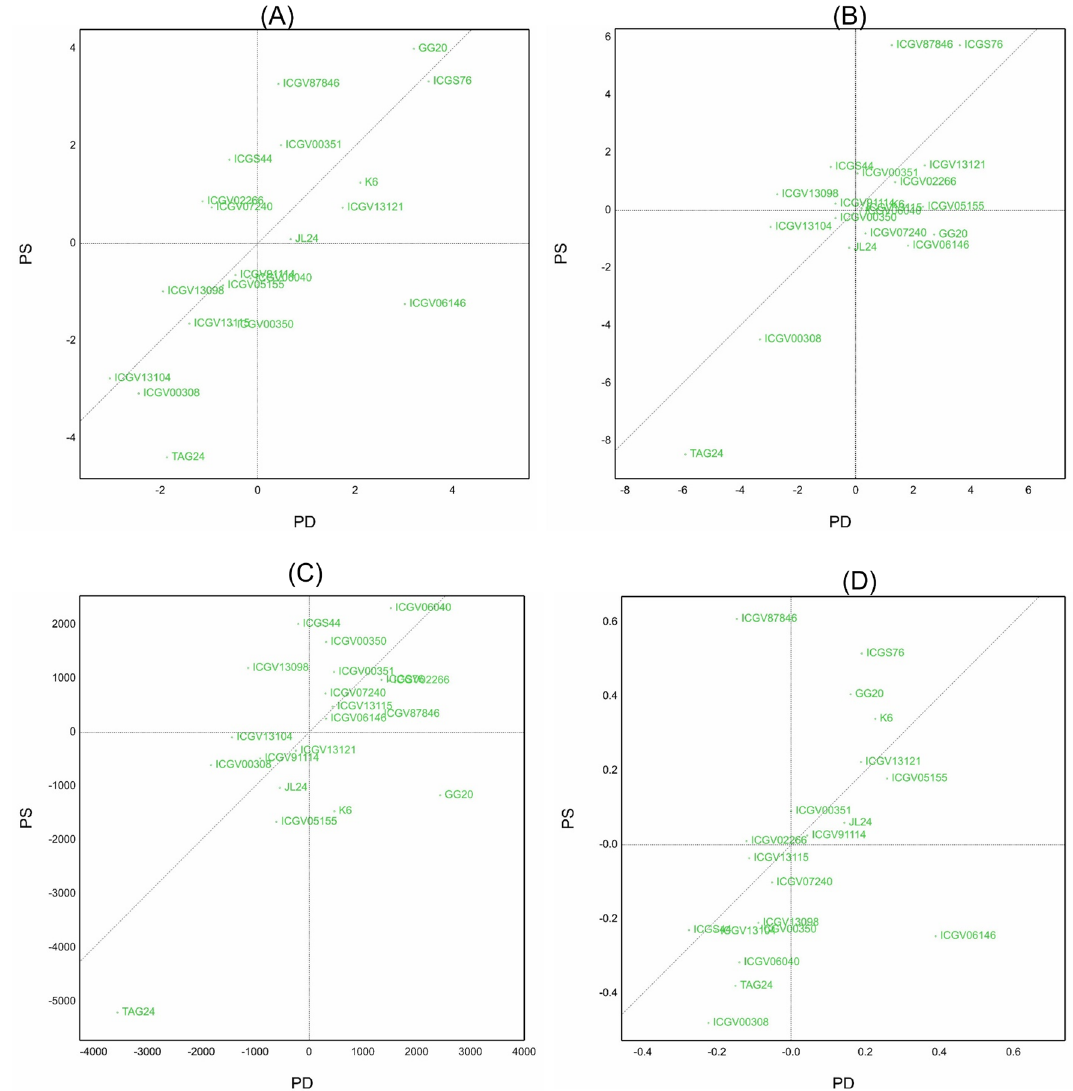
Figure 1. ( a ) Scatter plot showing distribution of genotypes for various traits under lysimeter experiment ( A ) Leaf dry weight (g) ( B ) stem dry weight (g). PD—Phosphorus deficiency; PS—Phosphorus sufficiency. ( b ) Scatter plot showing distribution of genotypes for various traits under lysimeter experiment ( C ) Total transpiration (g/kg) ( D ) Transpiration efficiency (g). PD—Phosphorus deficiency; PS—Phosphorus